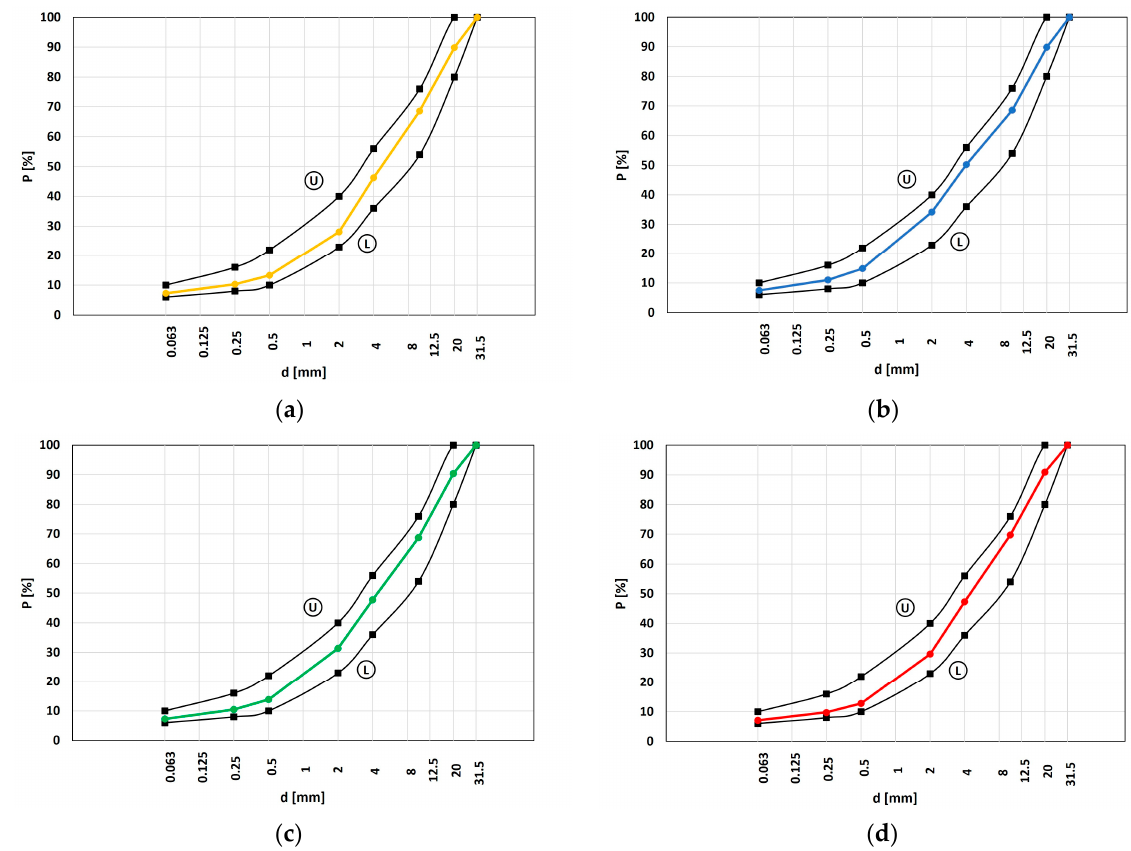
Figure 1. Grading curve of HMAs. ( a ) MA; ( b ) MB; ( c ) MC; ( d ) MD.